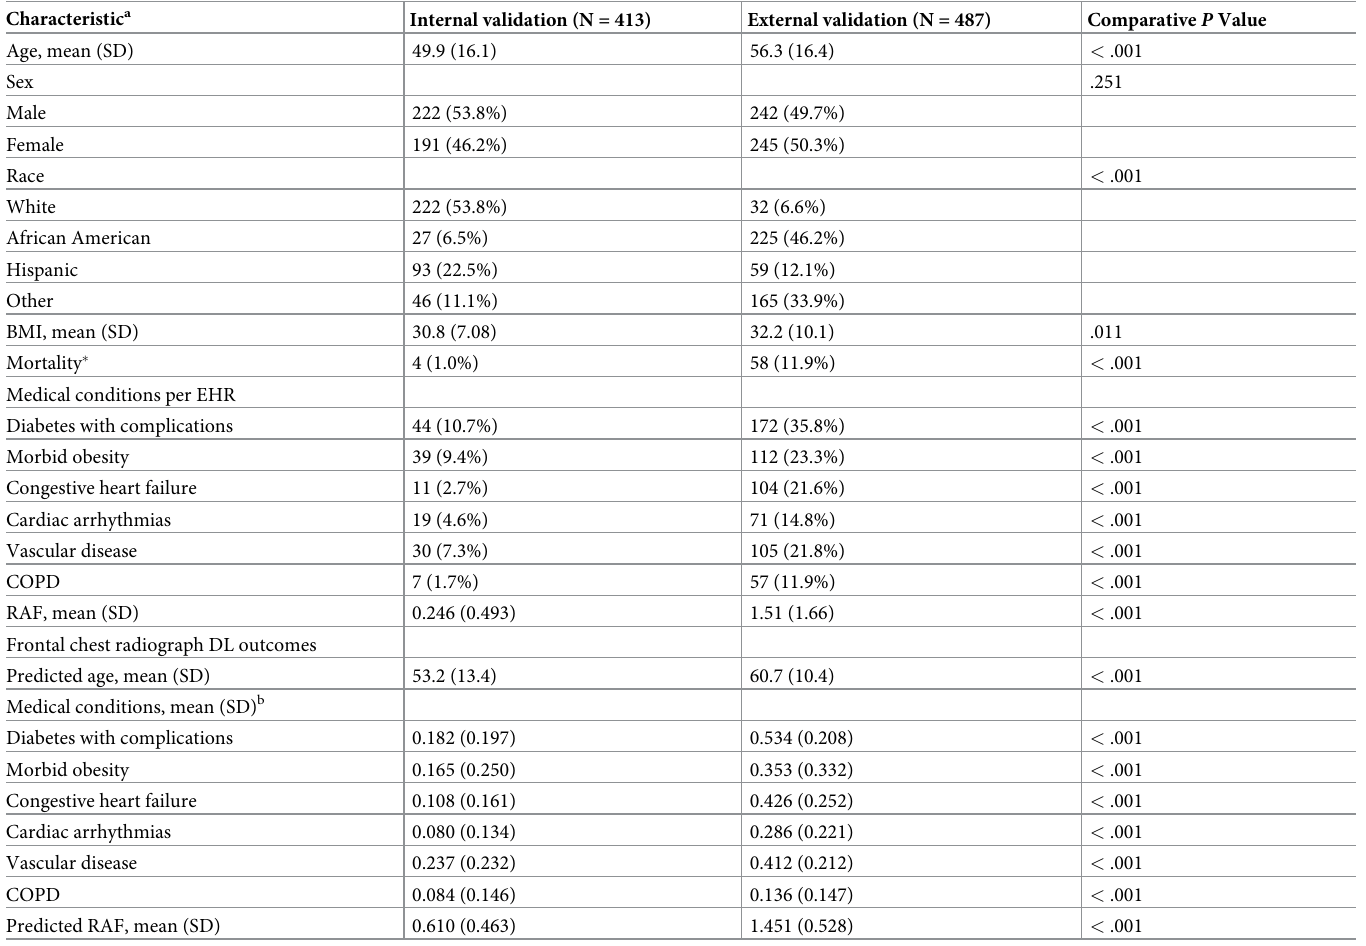
Table 1. Demographics, Clinical Findings and Deep Learning Chest Radiograph Characteristics per COVID-19 Cohort.